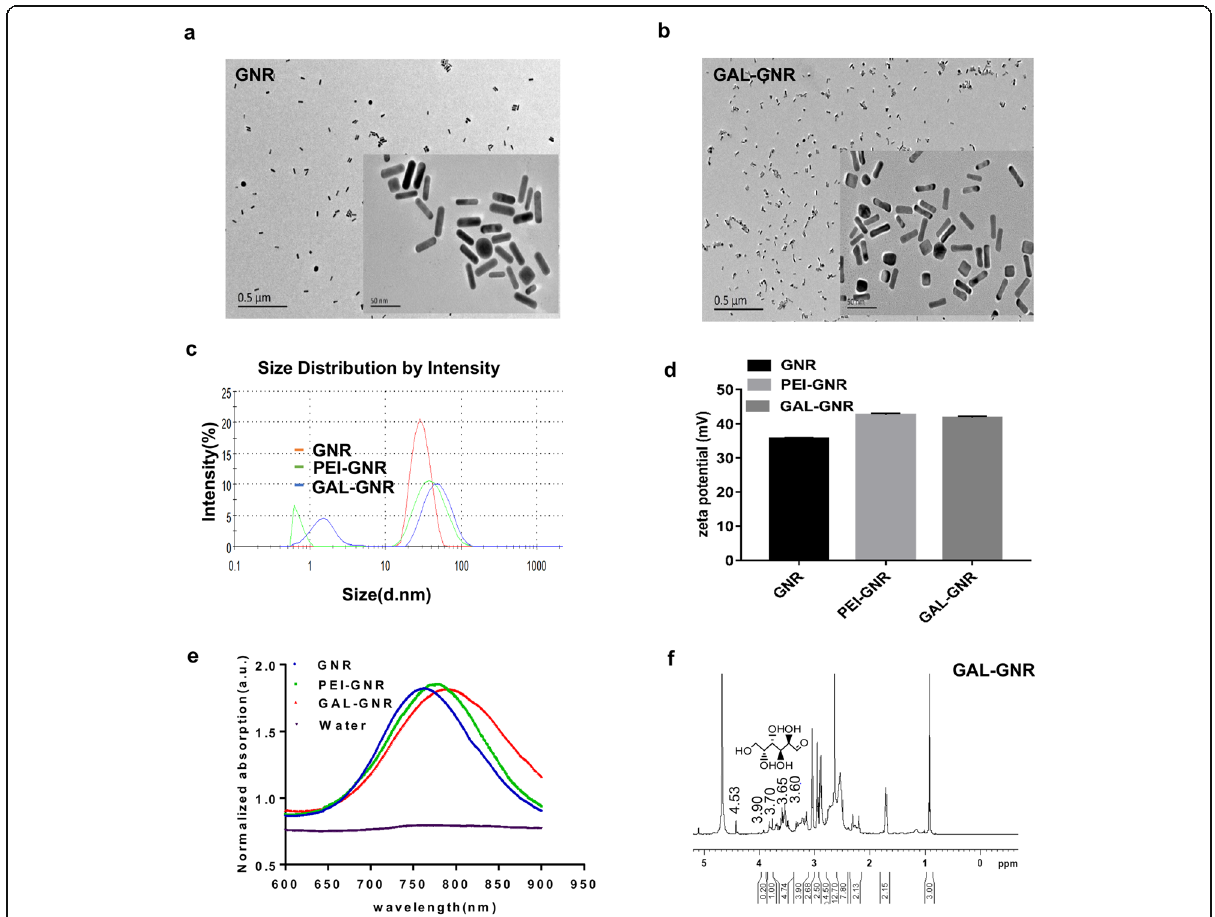
Fig. 1 Characterization of GNR and GAL-GNR. a TEM micrograph of GNR (scale = 0.5 μ m/50 nm). b TEM micrograph of GAL-GNR (scale = 0.5 μ m /50 nm). c Particle size analysis of different modified GNR. d Zeta potential analysis of different modified GNR (GAL-GNR). e Normalized UV – Vis absorption spectra of different modified GNR and water. f NMR absorbance spectra of